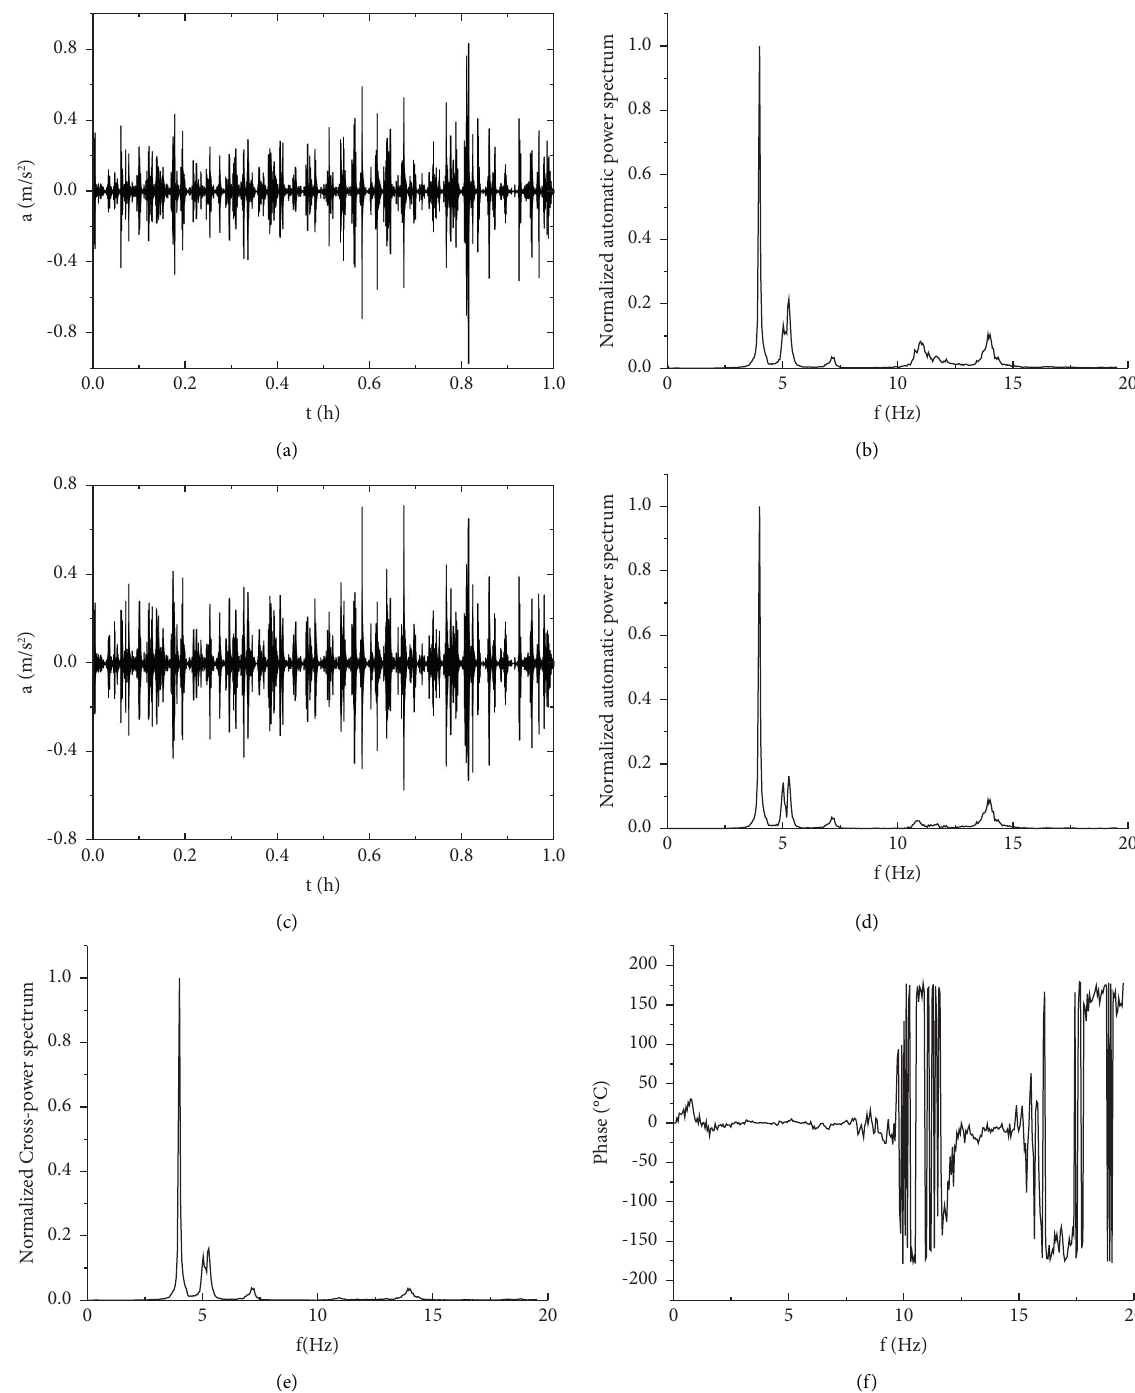
Figure 5: Measured time histories and their spectrum analysis. (a) Time course of acceleration at reference point V0. (b) Automatic power spectrum of the reference point V0. (c) Time course of acceleration across midpoint V1-4. (d) Automatic power spectrum for reference points V1-4. (e) Cross-power spectrum of the midspan measuring point V1-4 and the reference point V0. (f) Reference point V0 and cross- center V1-4 mutual power phase